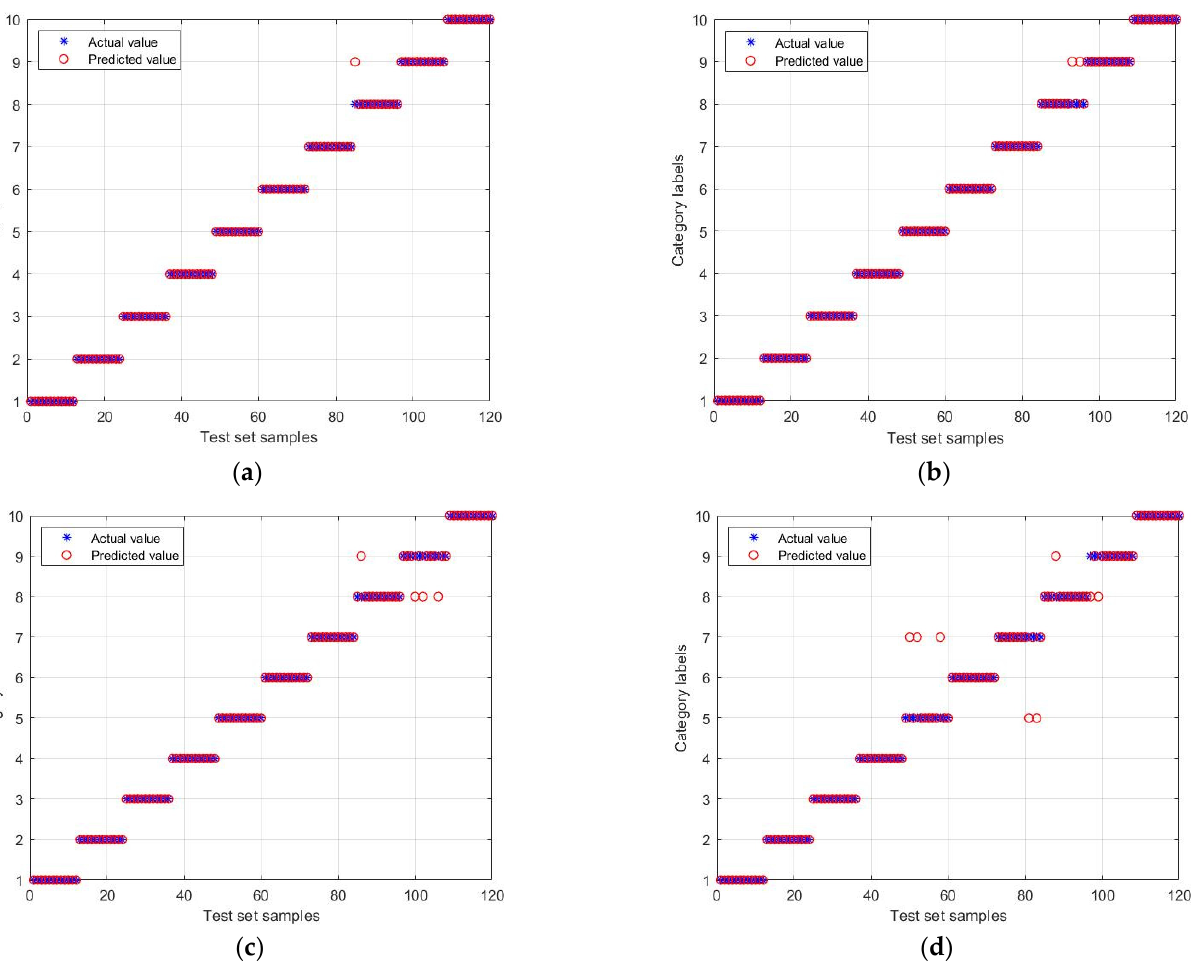
Figure 7. ( a ) GWO ‐ KELM model; ( b ) WOA ‐ KELM model; ( c ) GOA ‐ KELM model; ( d ) KELM model. Figure 7. ( a ) GWO-KELM model; ( b ) WOA-KELM model; ( c ) GOA-KELM model; ( d ) KELM model.